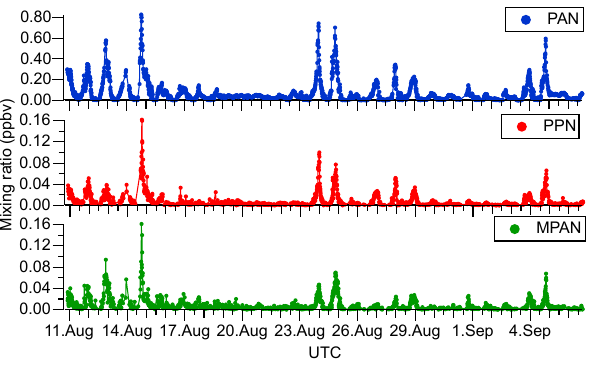
Figure 13. Time series of PAN, PPN, and MPAN during FOSSILS.